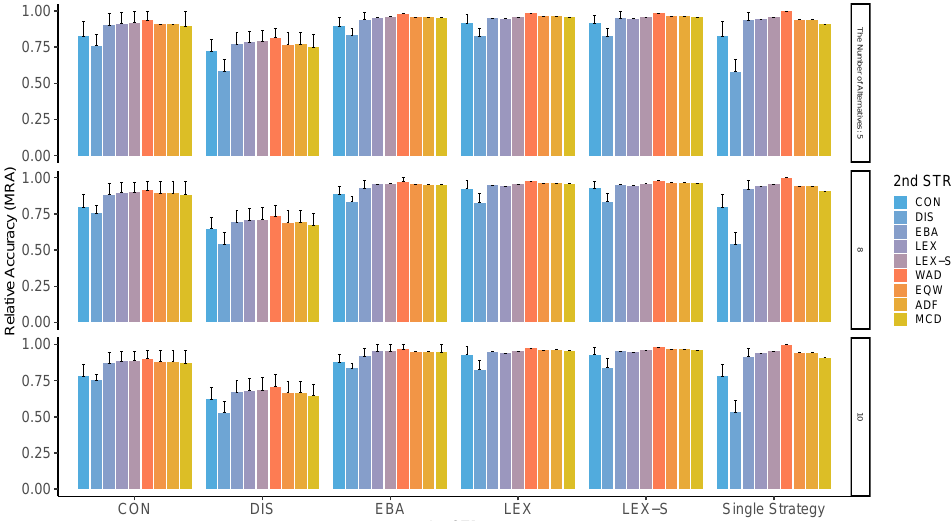
Figure A5. MRA in two-stage decision-making when only two alternatives are left in the second stage for the different numbers of alternatives. Note: ADF: additive difference; CON: conjunctive; DIS: disjunctive; EBA: elimination by aspects; EQW: equal-weighted strategy; LEX: lexicographic; LEX-S: lexicographic semi-order; MCD: majority of confirming dimensions; STR: strategy; WAD: weighted